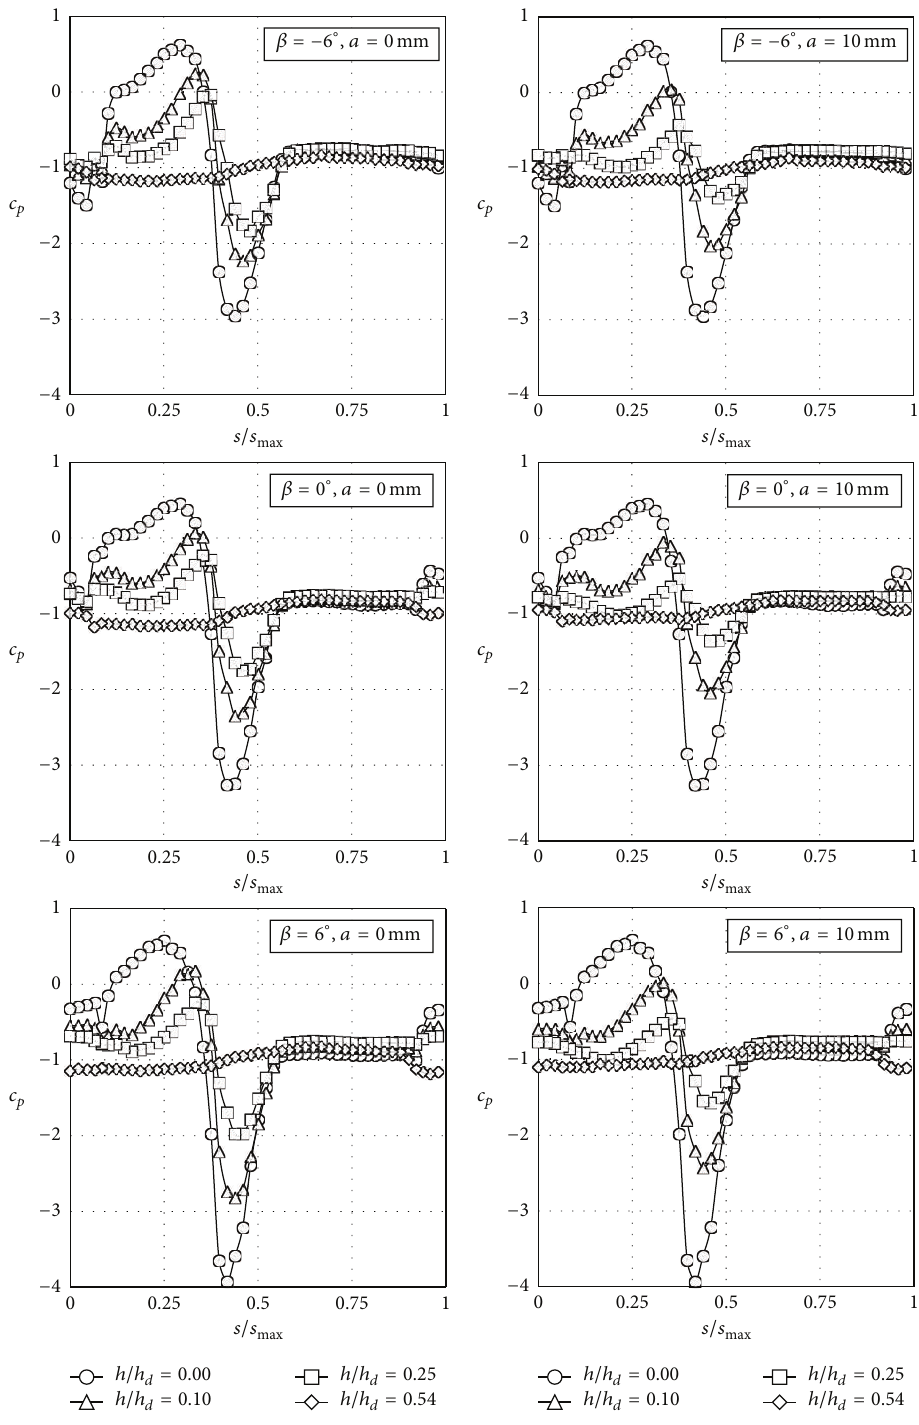
similar). Also, the results from the same windbreak and track configurations, but with changing the embankment slope, indicate a reduced effect of this parameter.